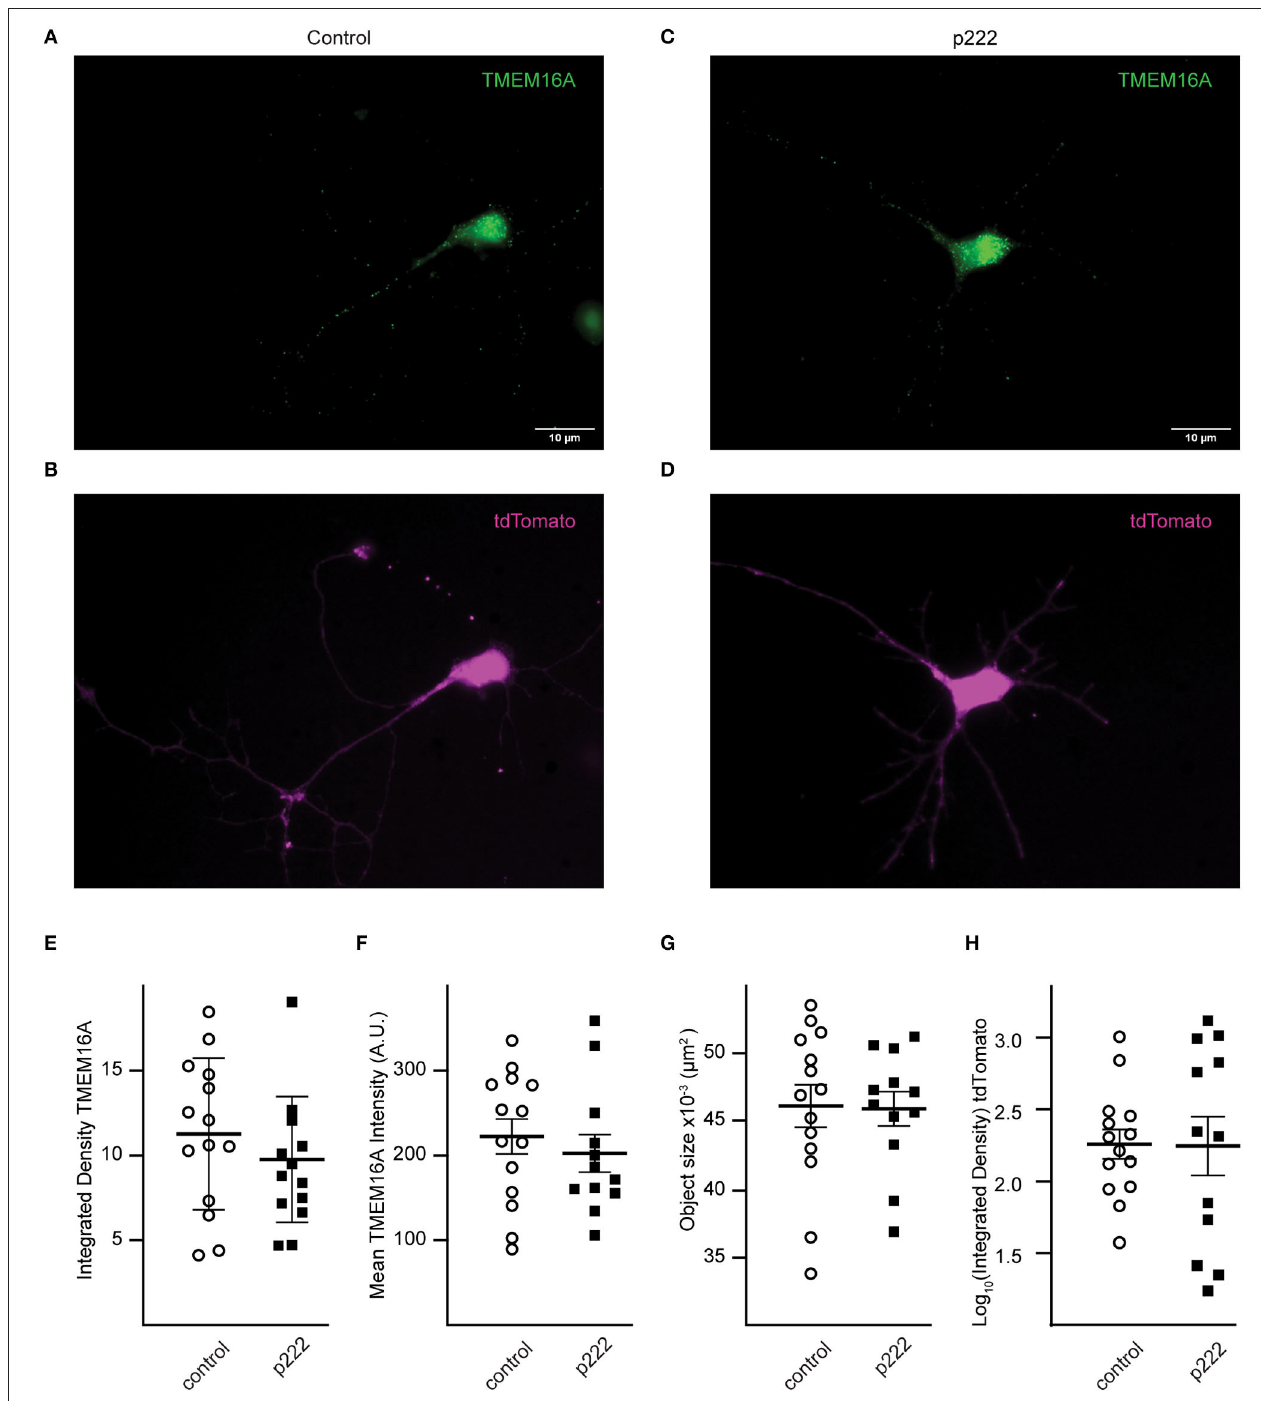
FIGURE 4 | Transfection with P222 has no effect on TMEM16A protein expression (A–D) . Representative images of TMEM16A antibody immunofluorescence and tdTomato fluorescence from e18 cells transfected with control plasmid (A,B) or p222 plasmid (C,D) targeting TMEM16A. (E) The mean integrated density for all objects identified within the TMEM16A mask; (F) the mean fluorescent intensity of the objects; (G) the mean objects size; (H) the log-transformed integrated density for tdTomato. There is no statistical difference between groups in (E–H) (two-tailed Welch’s t-tests ).